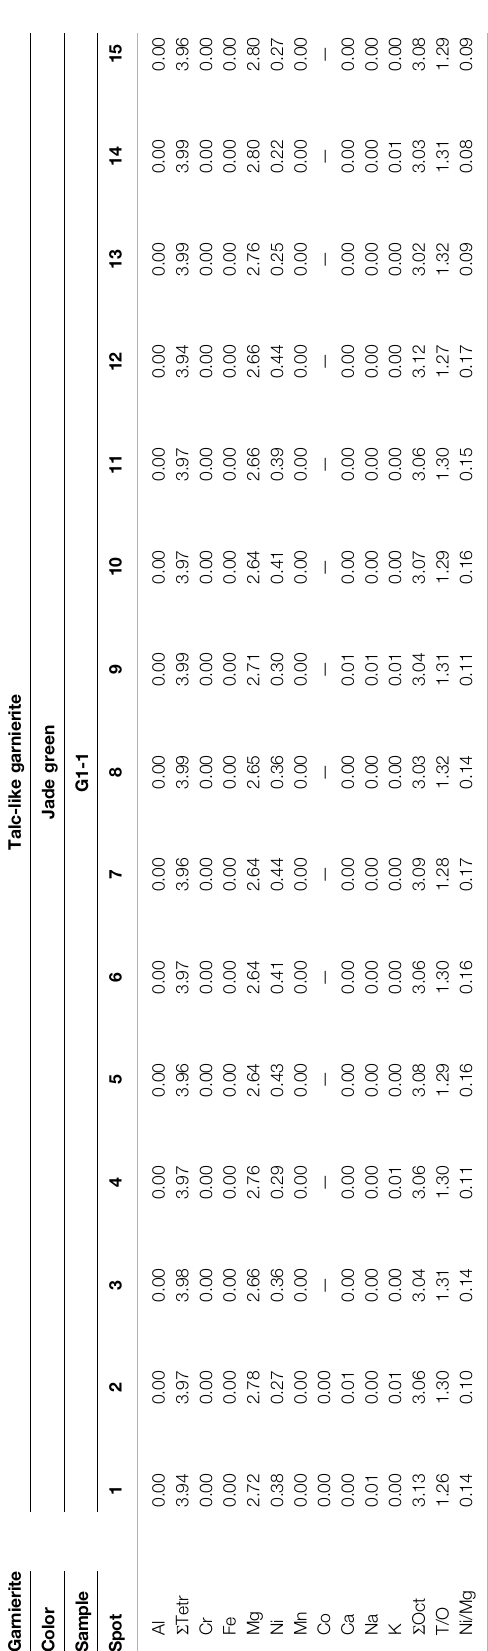
( Table 2 ). The general chemical formula for